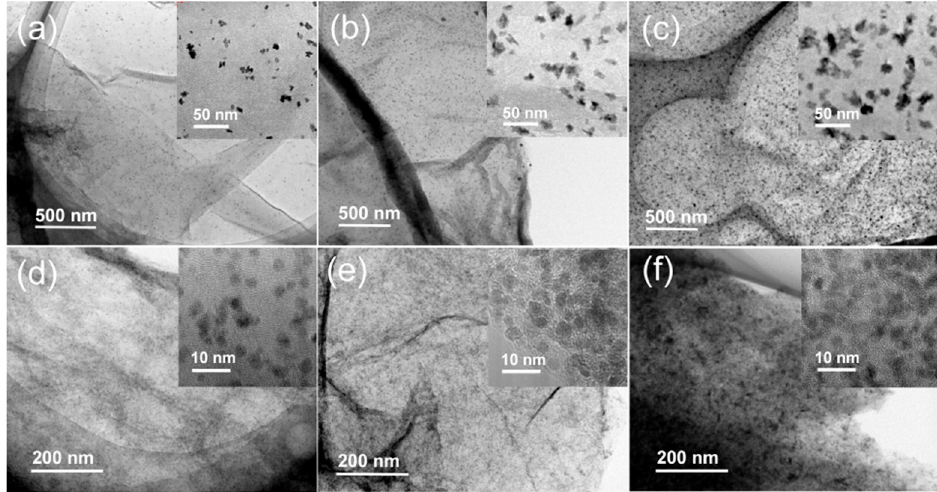
Figure 4. TEM images of Ru/graphene nanocomposites: ( a ) SS ‐ 20; ( b ) SS ‐ 40; ( c ) SS ‐ 60; ( d ) CS ‐ 40; ( e ) CS ‐ 60; and ( f ) CS ‐ 80.